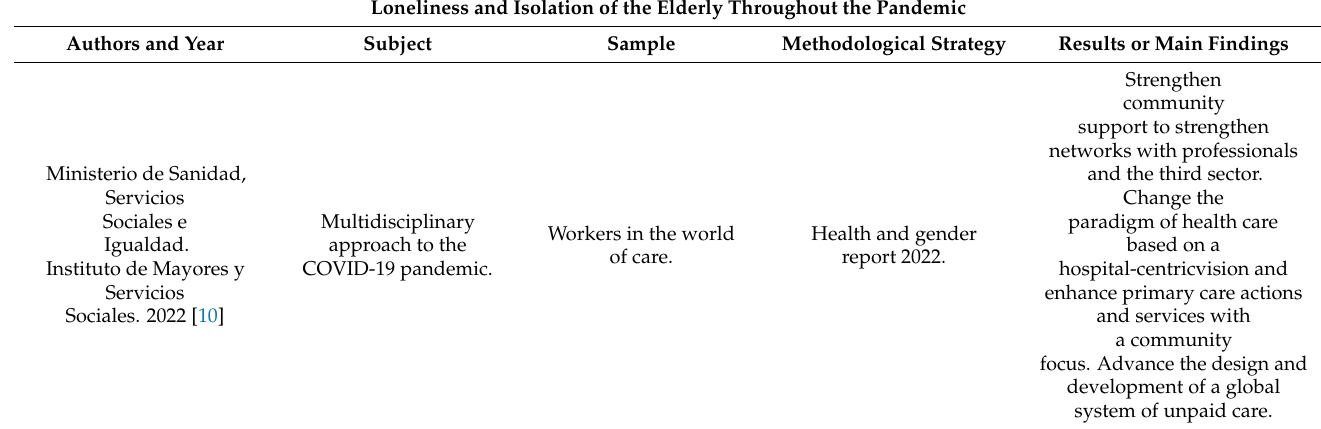
Table 5. Articles selected according to area and topic of interest. Source: own authors. Loneliness and Isolation of the Elderly Throughout the